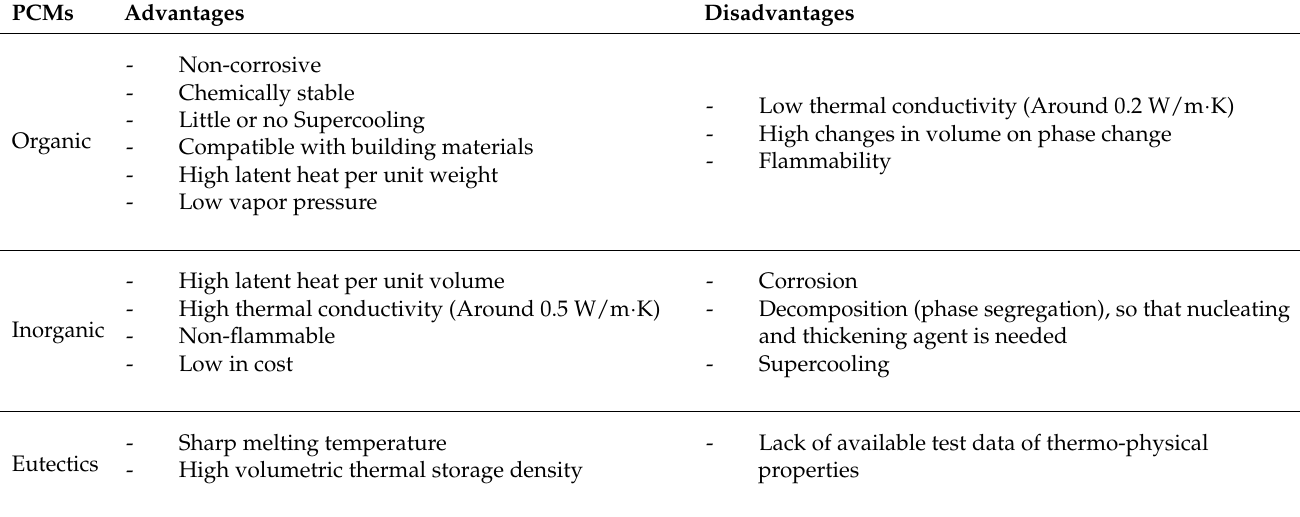
Table 1. Advantages and disadvantages of different type of PCM